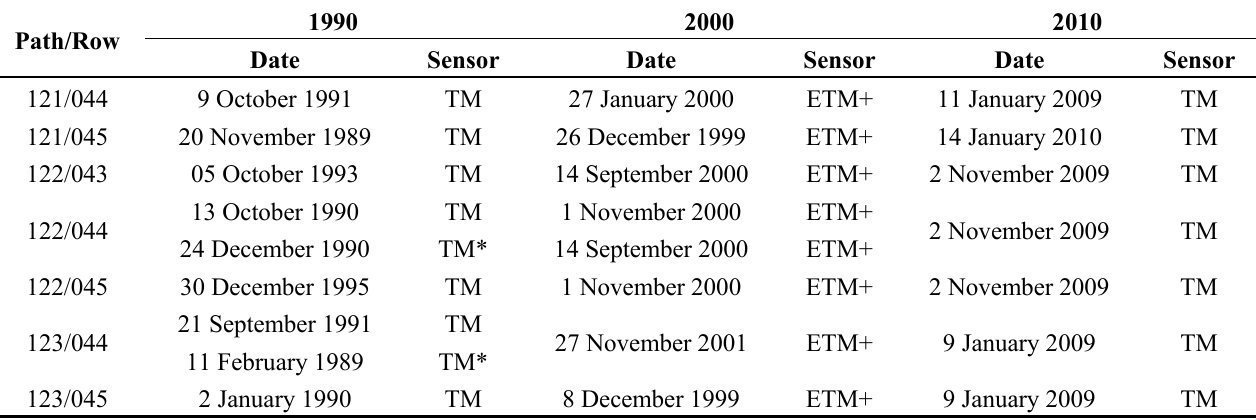
Table 1. List of Landsat images for land use detection in the PRD.